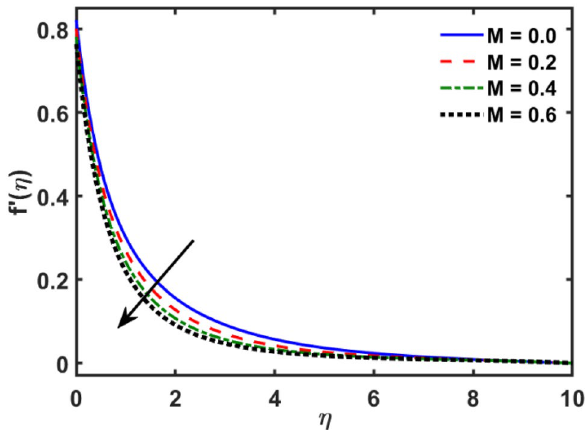
Figure 5. Variation of M on f ′ (η) .